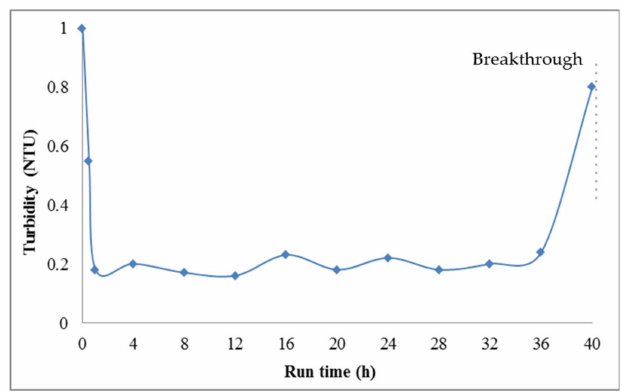
Figure 5. Turbidity as a function of run time for a typical filter run (reprepared using the data from